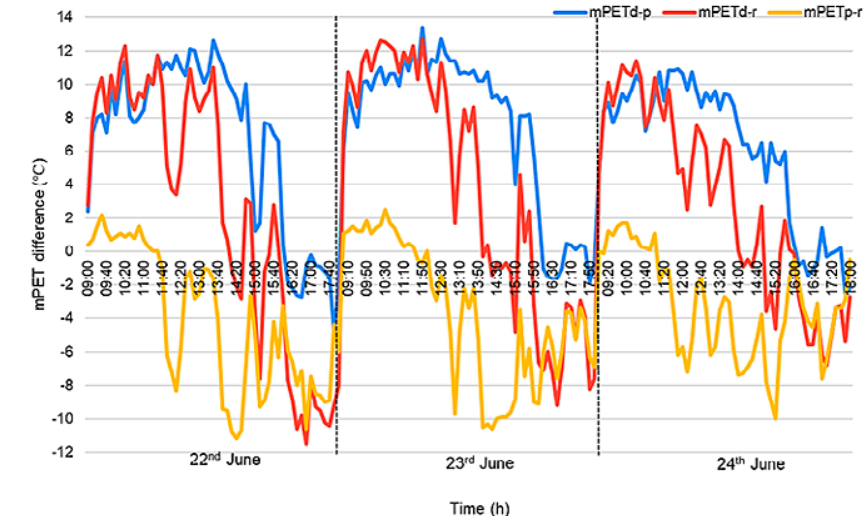
Figure 10. Temporal variation of mPET in Banja Luka (Bosnia and Herzegovina) in the period 22-24 June 2021 (measurement period 9-18 h CEST). NOTE: mPET represents modified Physiologically Equivalent Temperature d-p difference between downtown and urban park; mPET represents modified Physiologically Equivalent Temperature d-r difference between downtown and riverside; and mPET represents modified Physiologically Equivalent Temperature p-r difference between urban park and